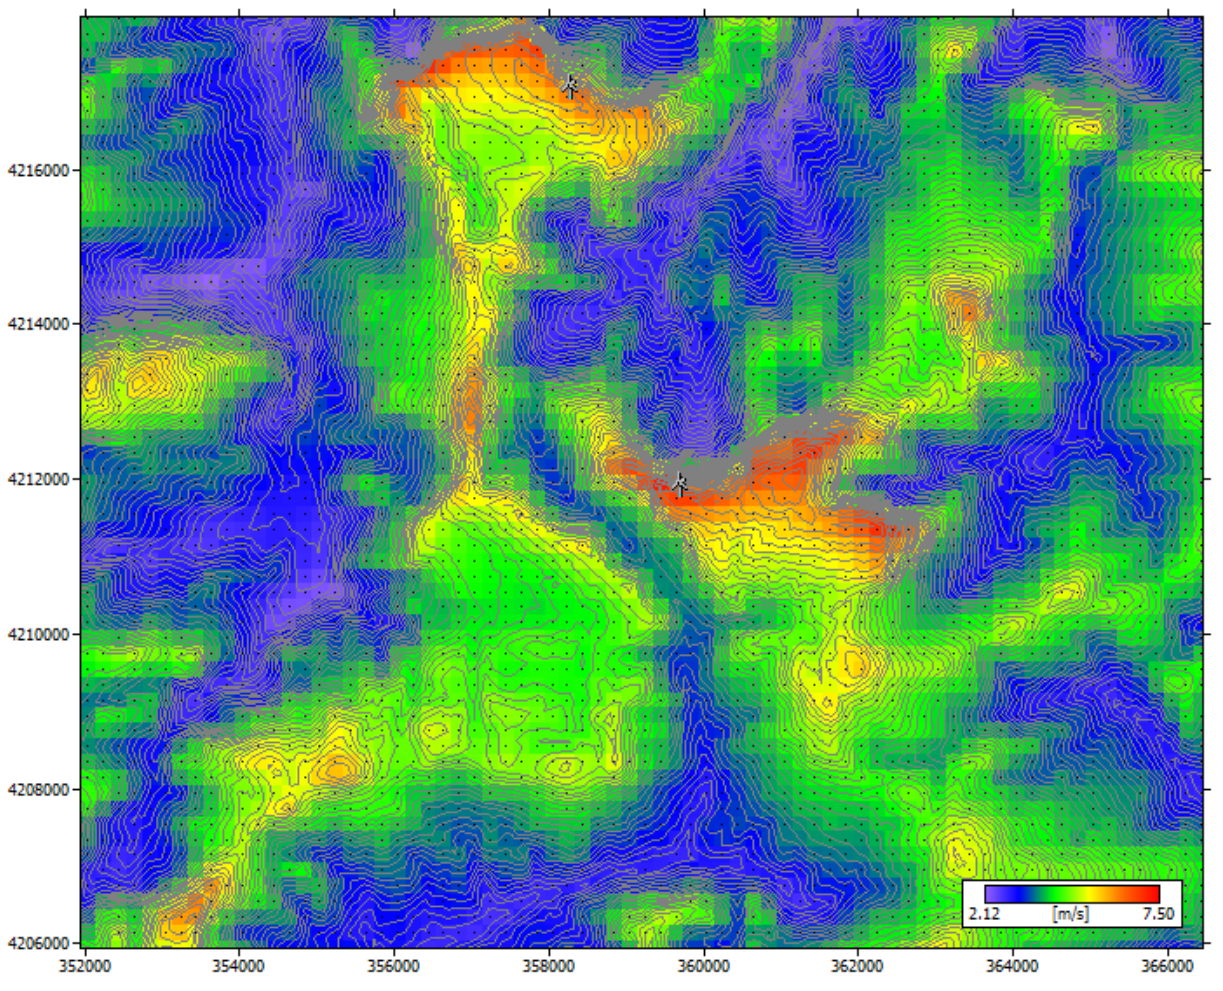
Figure 6. A population map of the area and road